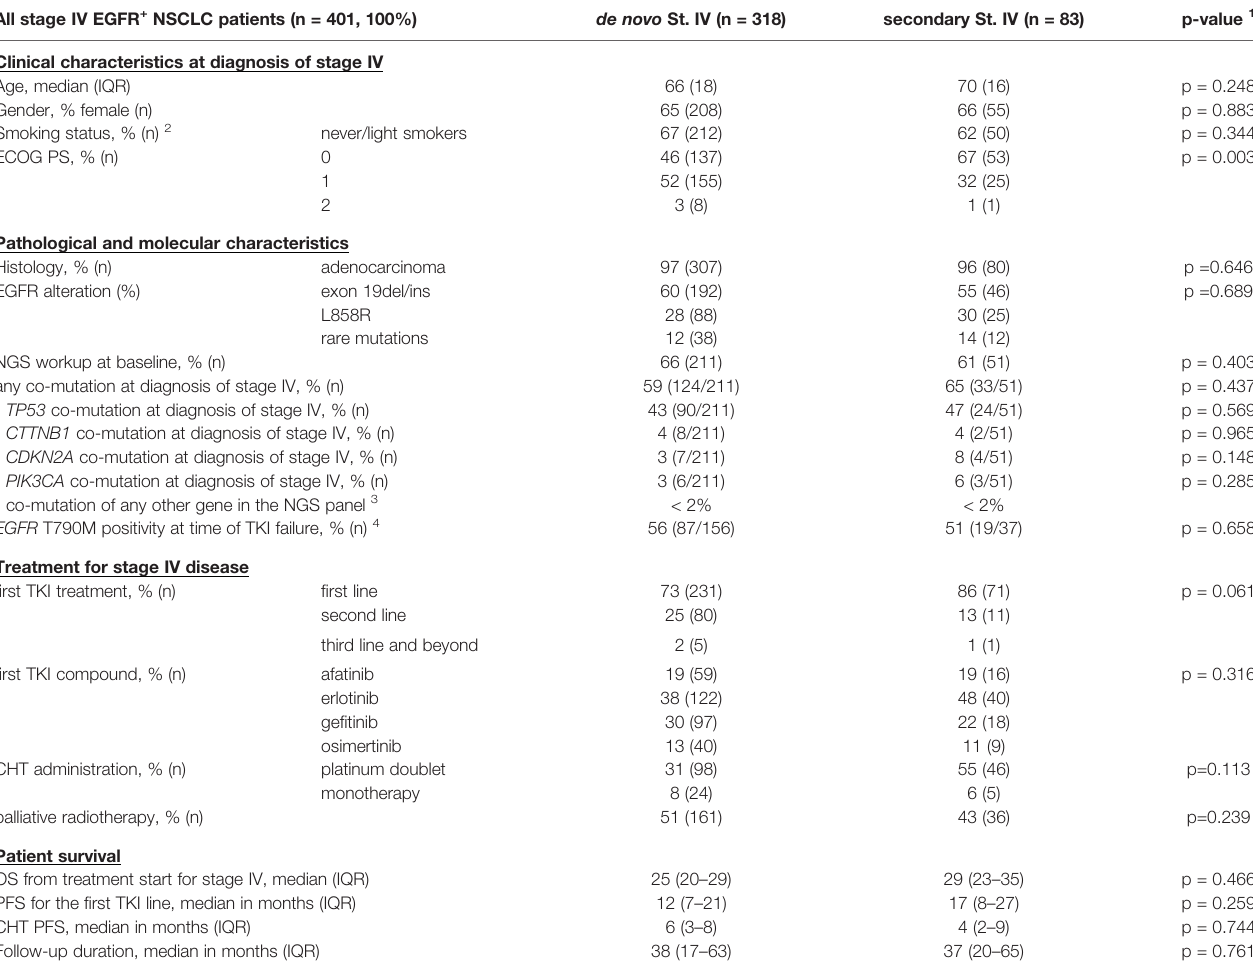
TABLE 1 | Patient characteristics. All stage IV EGFR + NSCLC patients (n = 401, 100%)